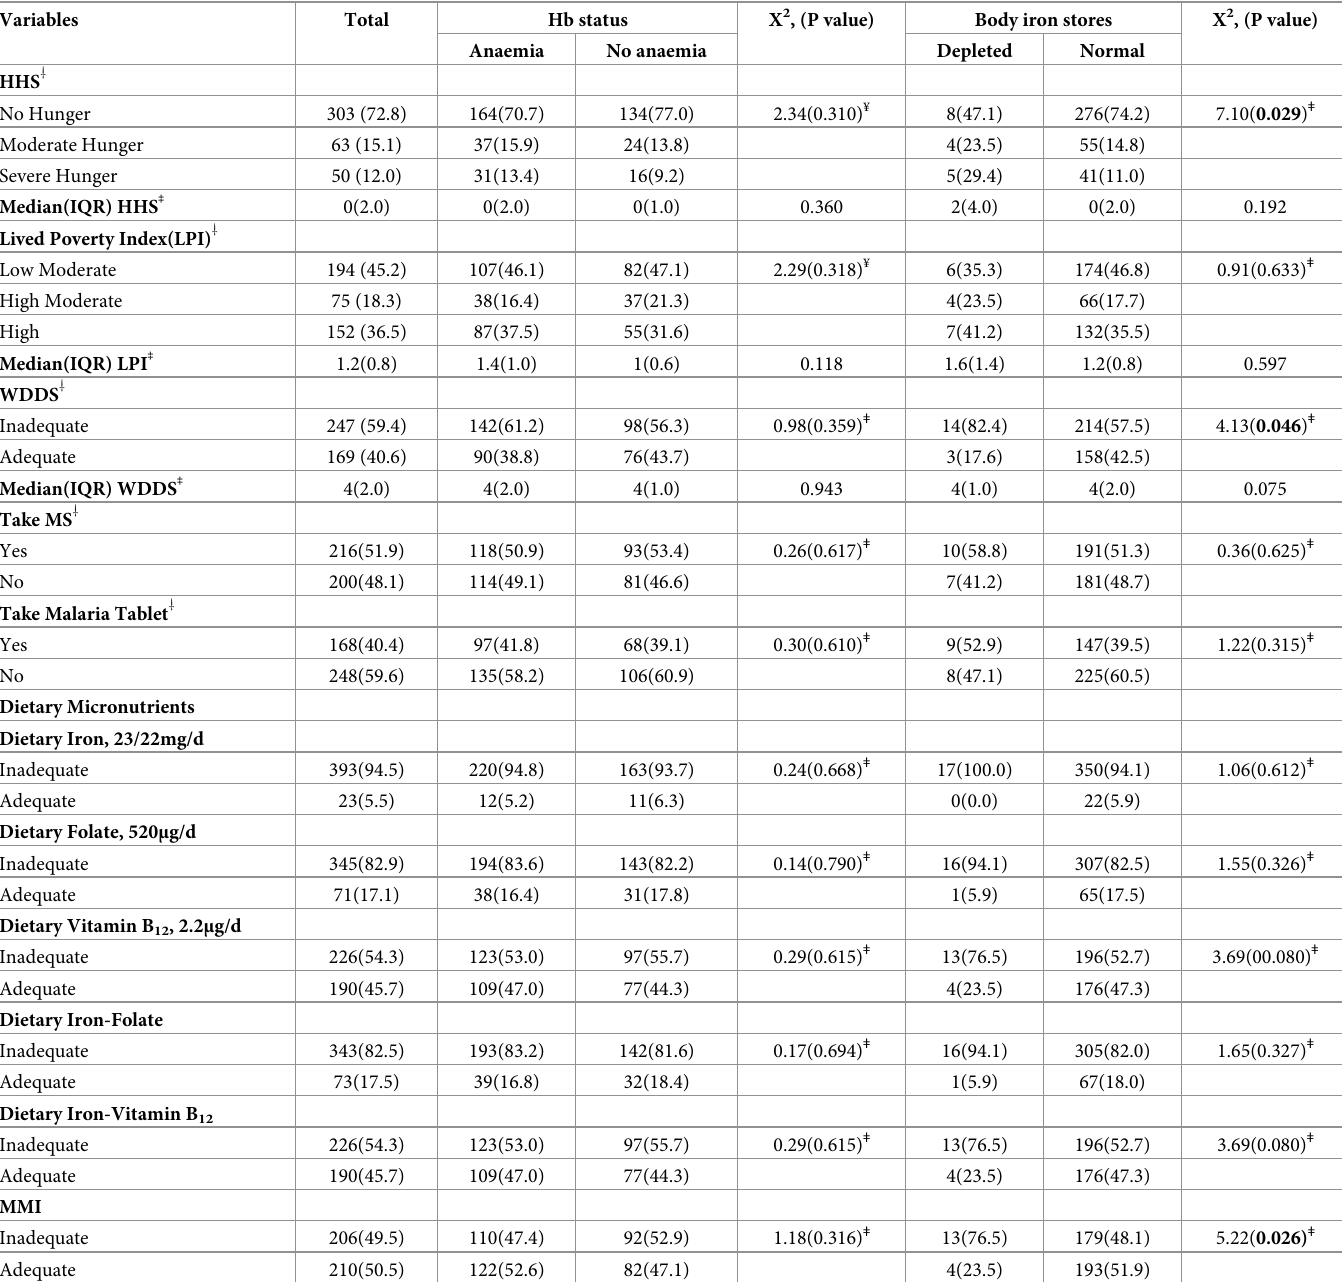
Table 1. Iron deficiency status, and household hunger scale, lived poverty index, intervention received at ANC, and micronutrient